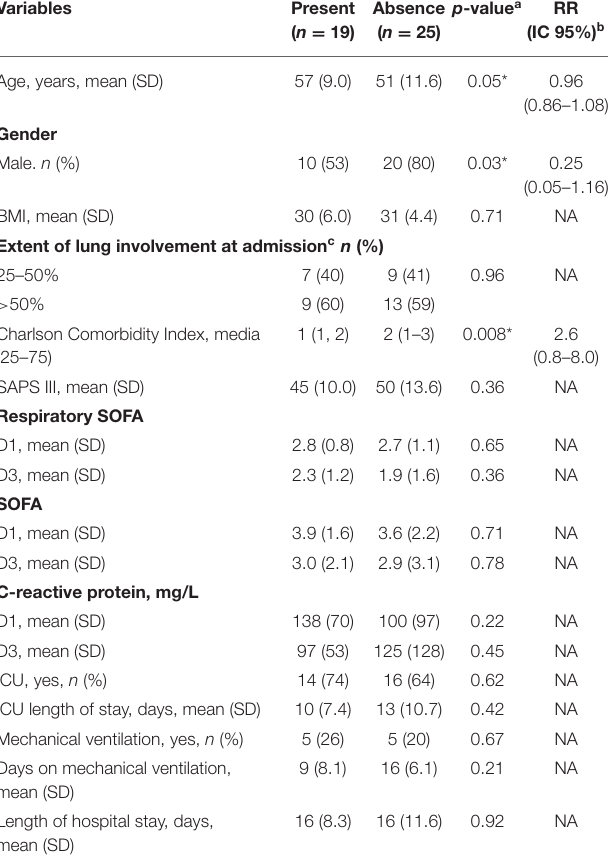
TABLE 6 | Variables associated with a decreased maximum inspiratory pressure 6-months after hospital discharge.